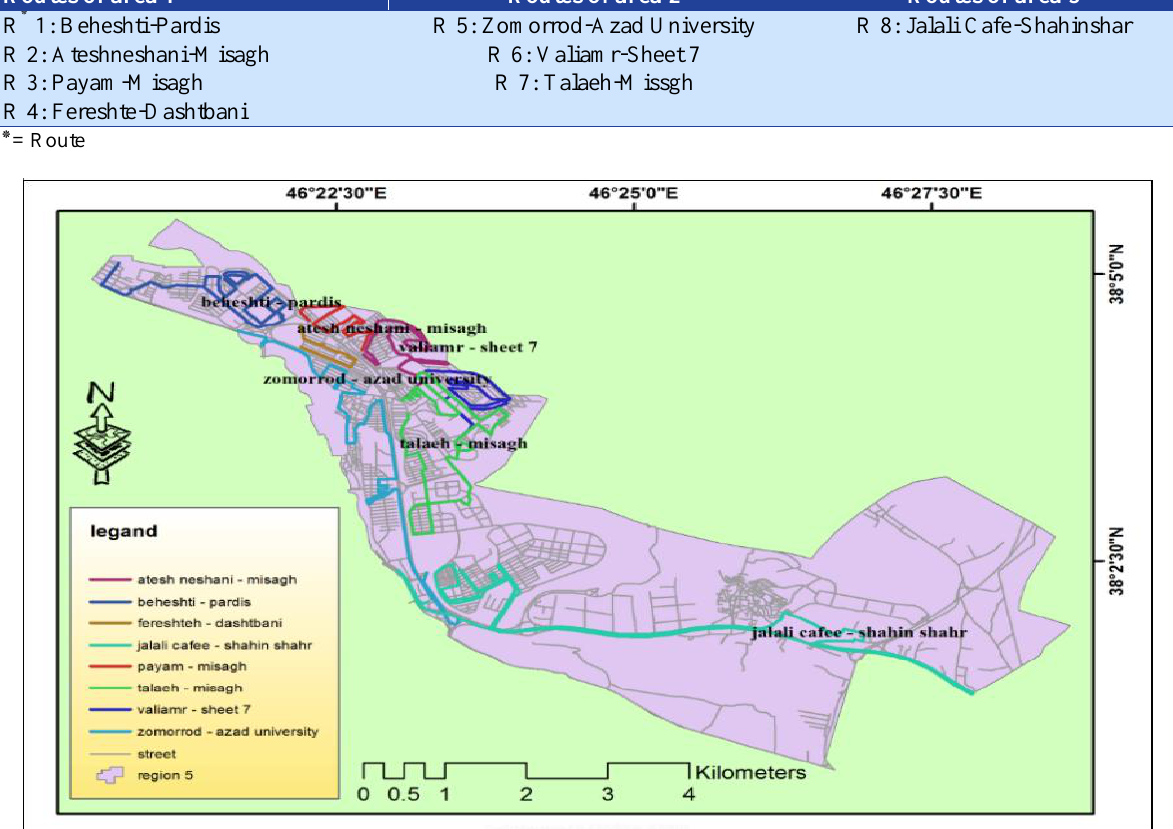
Figure 2. Map of the waste collection and transportation